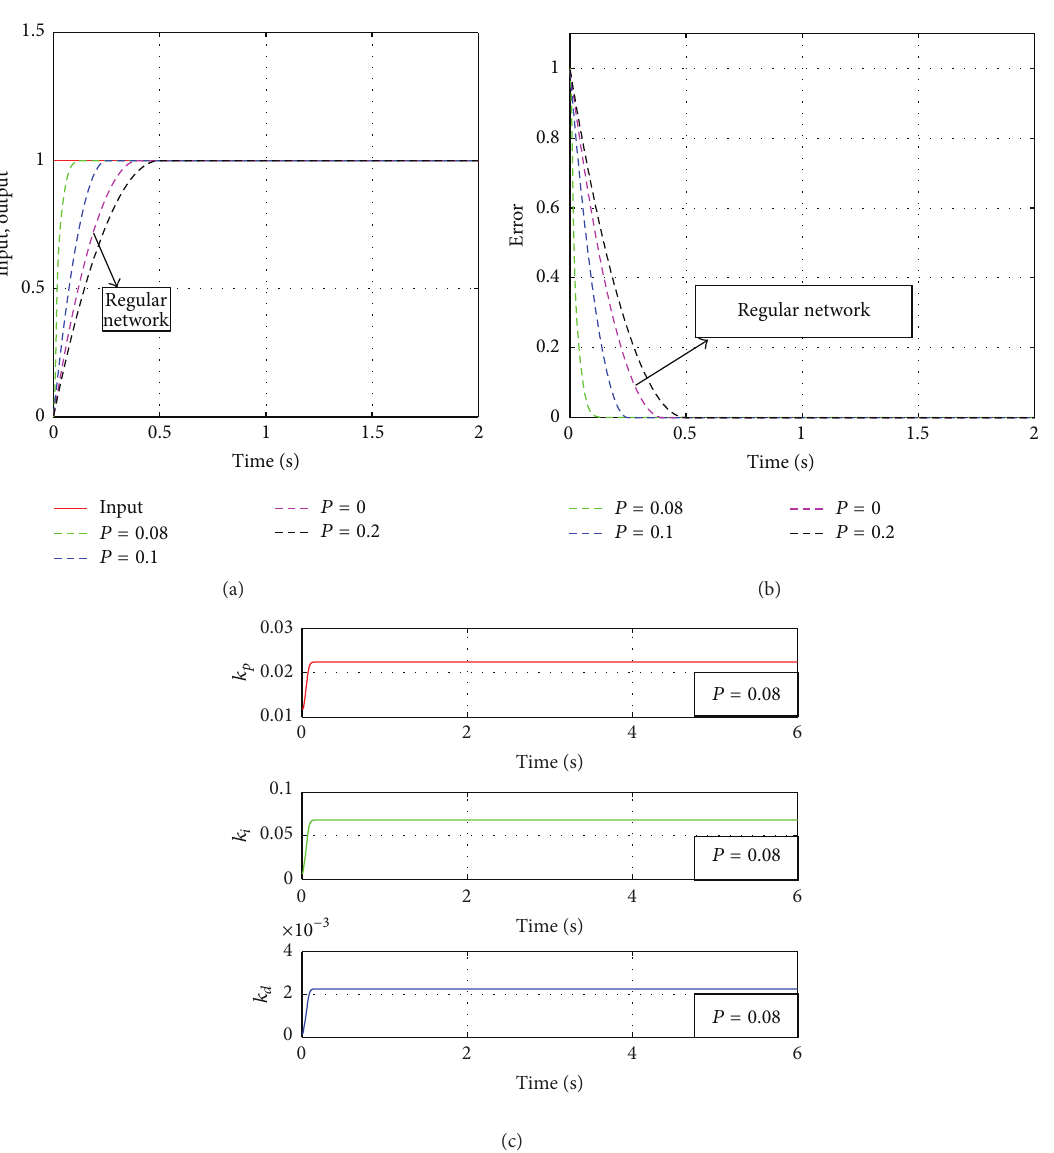
(𝑘) = 1.0) under a different rewiring probability 𝑃 . (a) in